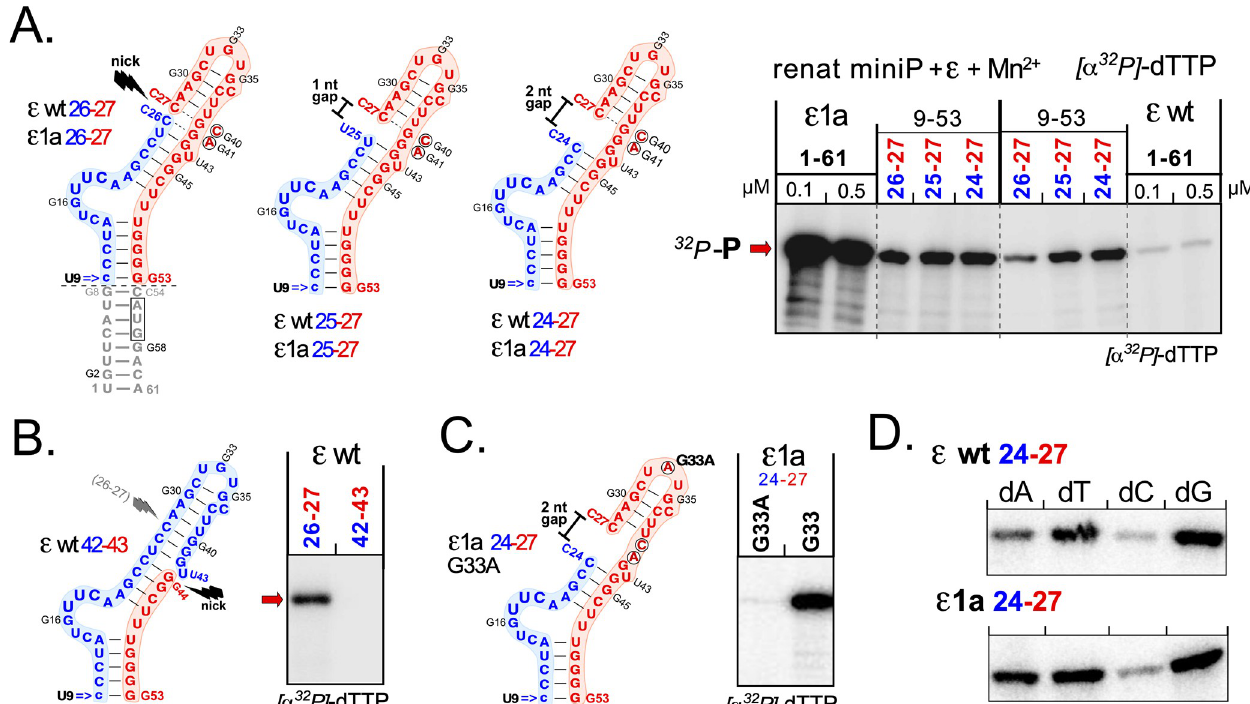
Fig 7. Bipartite ε RNAs enable in vitro priming in the absence of destabilizing ε 1a mutations. (A) Synthetic split ε RNAs. Omitting the bottom half of the lower stem (nt U1-G8 and C54-A61, i.e. retaining the sequence 9–53; grey lettering) two kinds of chemically synthesized RNAs were annealed. The 5´ proximal oligos (blue) spanned nt 9 (changed from U > c for a more stable c9-G53 pair) to positions C26, U25, or C24; the 3´proximal oligos (red ) comprised nt C27-G53, either with the wt G residues at positions 40 and 41, or with the G40C plus G41A mutations from ε 1a. Annealing of the oligos ending at position 26 and starting at 27 should give ε wt and ε 1a stem-loops with a nick; oligos ending at positions 25 and 24 would create one and two nt gaps ( middle and right ). The indicated annealed oligos (at 0.5 μ M final concentration), and for comparison in vitro transcripts comprising the contiguous full-length stem- loops ε 1a and ε wt (at 0.1 and 0.5 mM), were subjected to in vitro priming with α 32 P-dTTP and renatured HBV miniP. (B) The split position affects in vitro priming template activity. Two RNA oligos spanning ε positions 9–42 and G43-G53 were annealed ( ε wt 42–43) and used for dTTP priming as in A, in parallel to ε wt 26–27 as in A. (C) A pgRNA packaging preventing loop mutation (G33A) inhibits in vitro priming activity of gapped ε 1a RNA. RNA stem-loop ε 1a 24–27 and its G33A homolog were examined side-by-side by in vitro dTTP priming. (D) Gapped ε stem-loops display comparable dNTP preferences as contiguous in vitro transcripts. The indicated gapped stem-loops were subjected to in vitro priming with renatured HBV miniP and each of the four natural dNTPs, as in Fig 5B. Both synthetic stem-loops gave the strongest signals with dTTP and dGTP, followed by dATP and finally